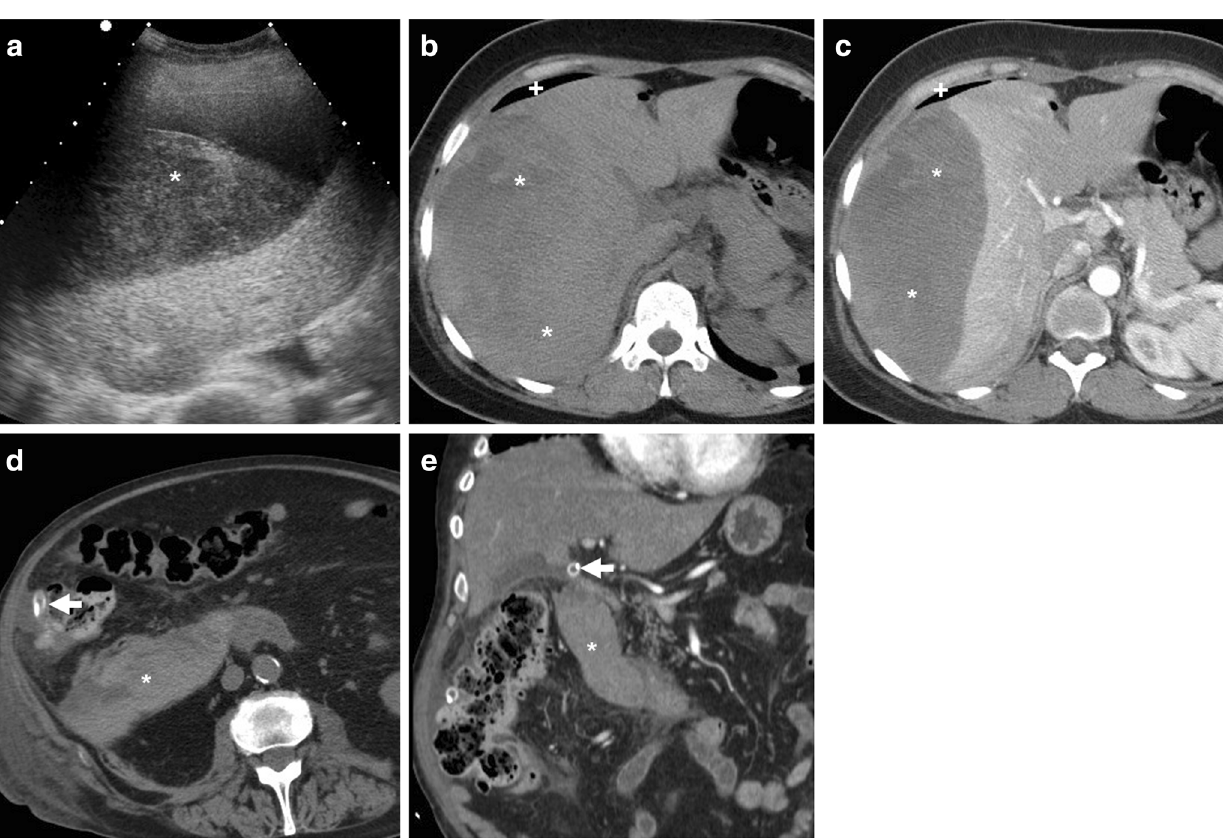
Fig. 13 Atypical sites of post-cholecystectomy bleeding. Vast subcapsu- lar haematoma (*) seen on ultrasound ( a ), precontrast ( b ) and enhanced ( c ) CT 24 h after laparoscopic cholecystectomy, causing compression of the liver, treated by percutaneous drainage and transfusions. Noteresidual intraperitoneal air (+) d , e Paraduodenal and anterior pararenal haematoma (*) seen on unenhanced ( d ) CT on the 3rd postoperative